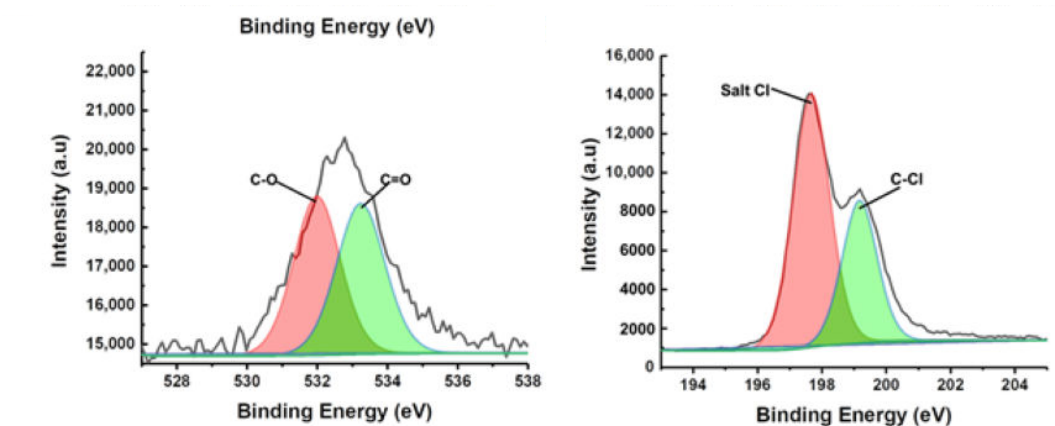
Figure 3. ( a ) FTIR spectrum of C-dots. ( b ) XPS survey spectrum of C-dots. ( c1 ) High-resolution C1s XPS. ( c2 ) High-resolution N1s XPS. ( c3 ) High-resolution O1s XPS. ( c4 ) High-resolution Cl XPS.